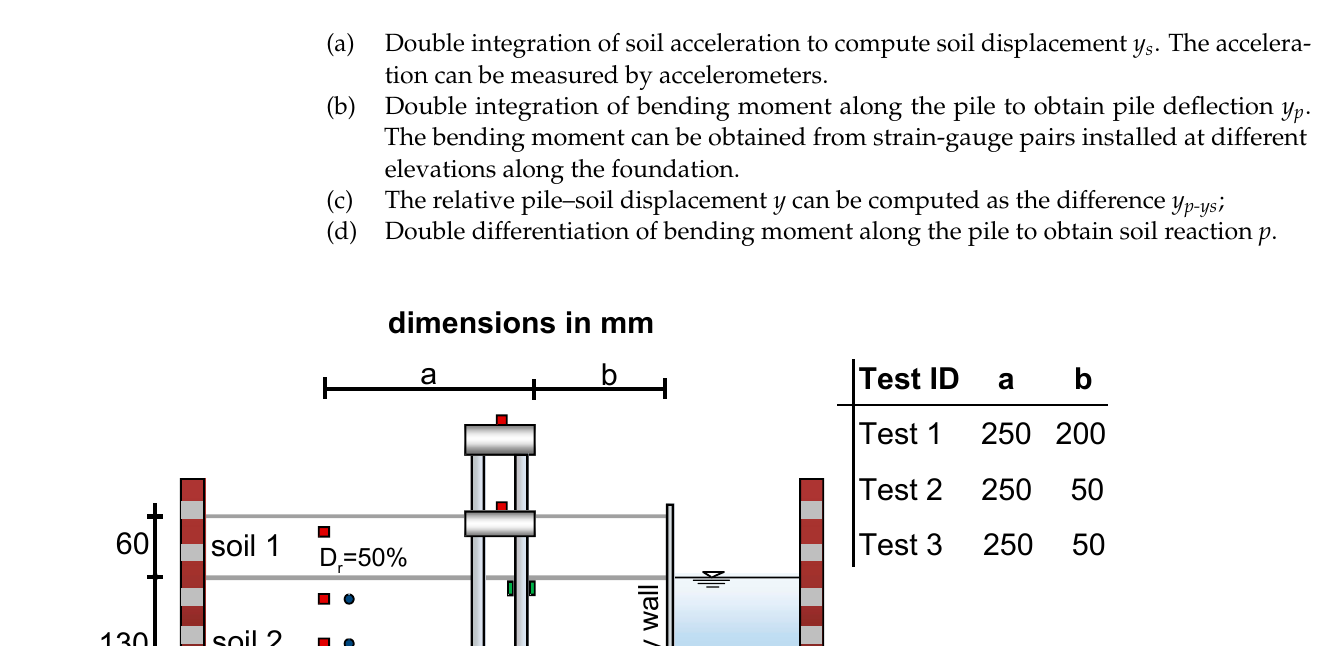
Figure 43. Back-calculated p–y curves from centrifuge tests.